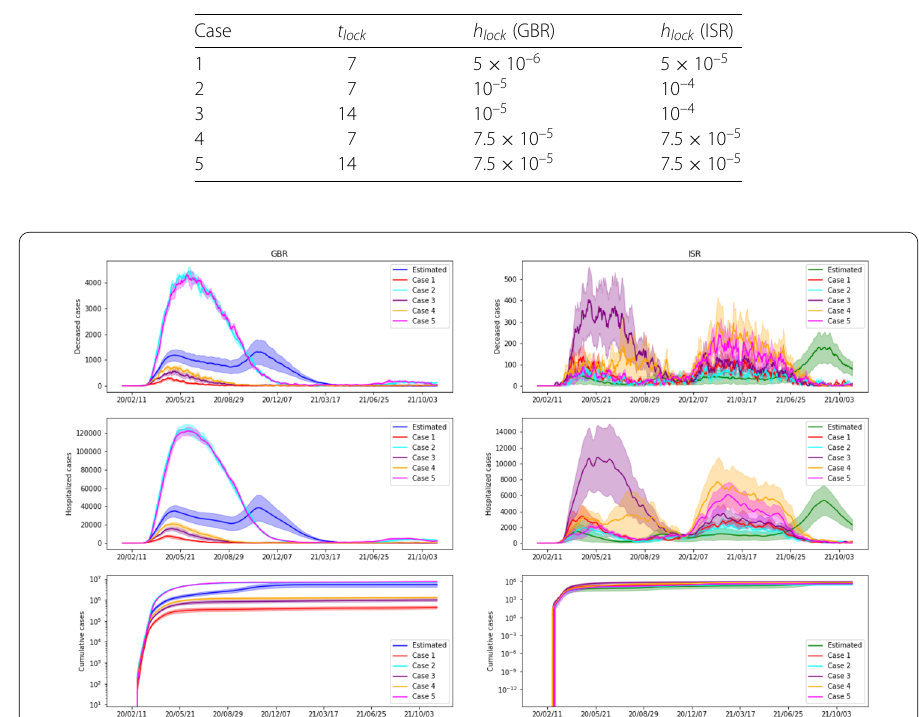
Figure 14 Scenario10 . Simulations with cases-imposed lockdown, for different combinations of parameters h lock and t lock (see Table 4). We present cumulative cases, hospitalized and deceased for both GBR (on the left) and ISR (on the right)